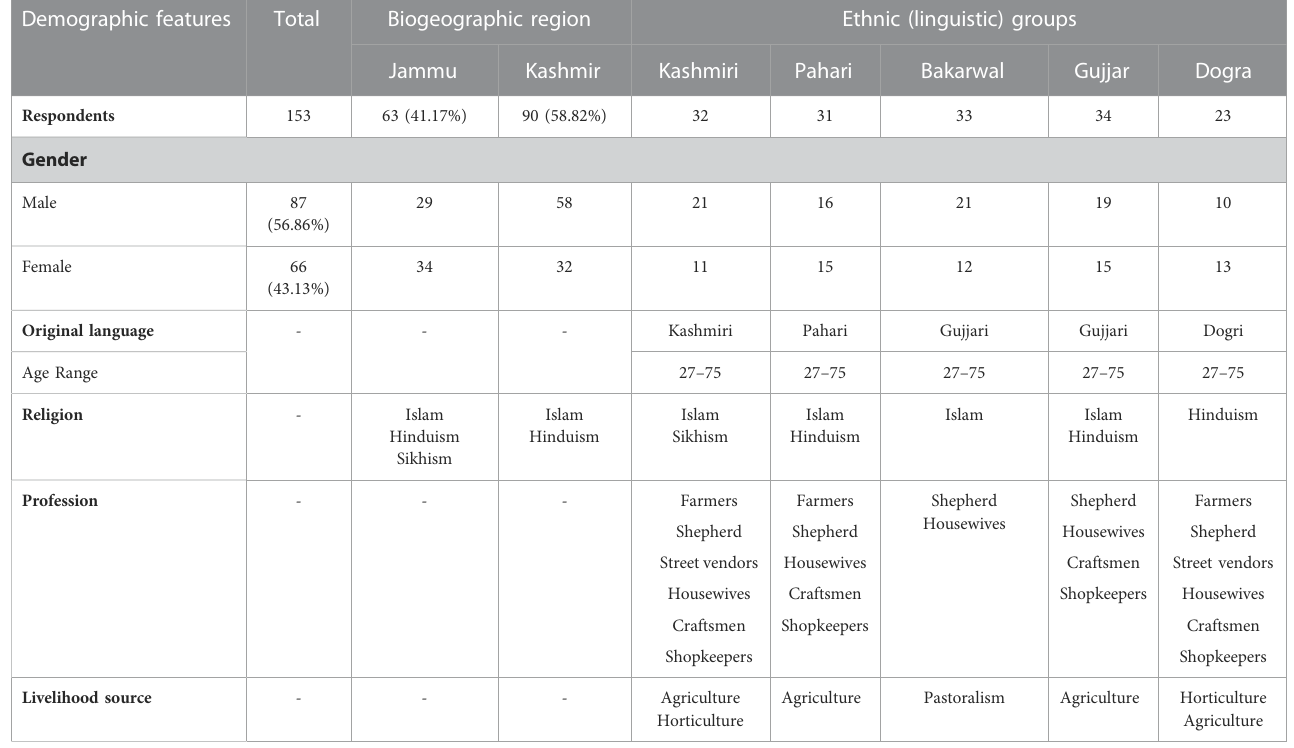
TABLE 1 Demographic status of the respondents from Jammu and Kashmir, the western Himalayas, India. Demographic